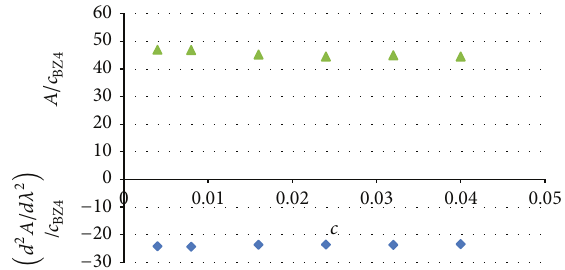
Table 2: Chromatographic determinations of BZ4 in the